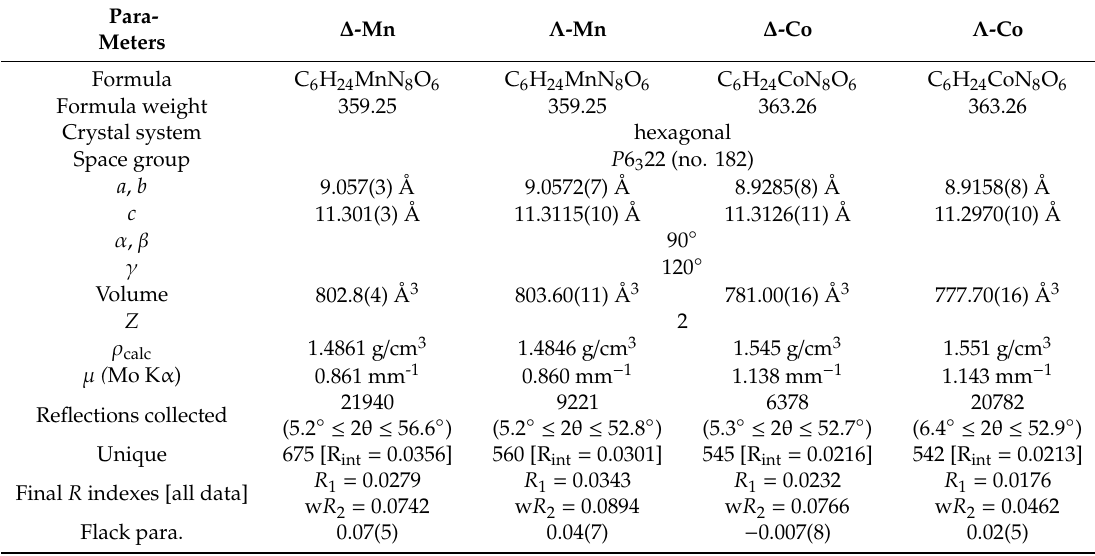
Table 1. Crystal data and structure refinement for [M(en) 3 ](NO 3 ) 2 at 298 K.